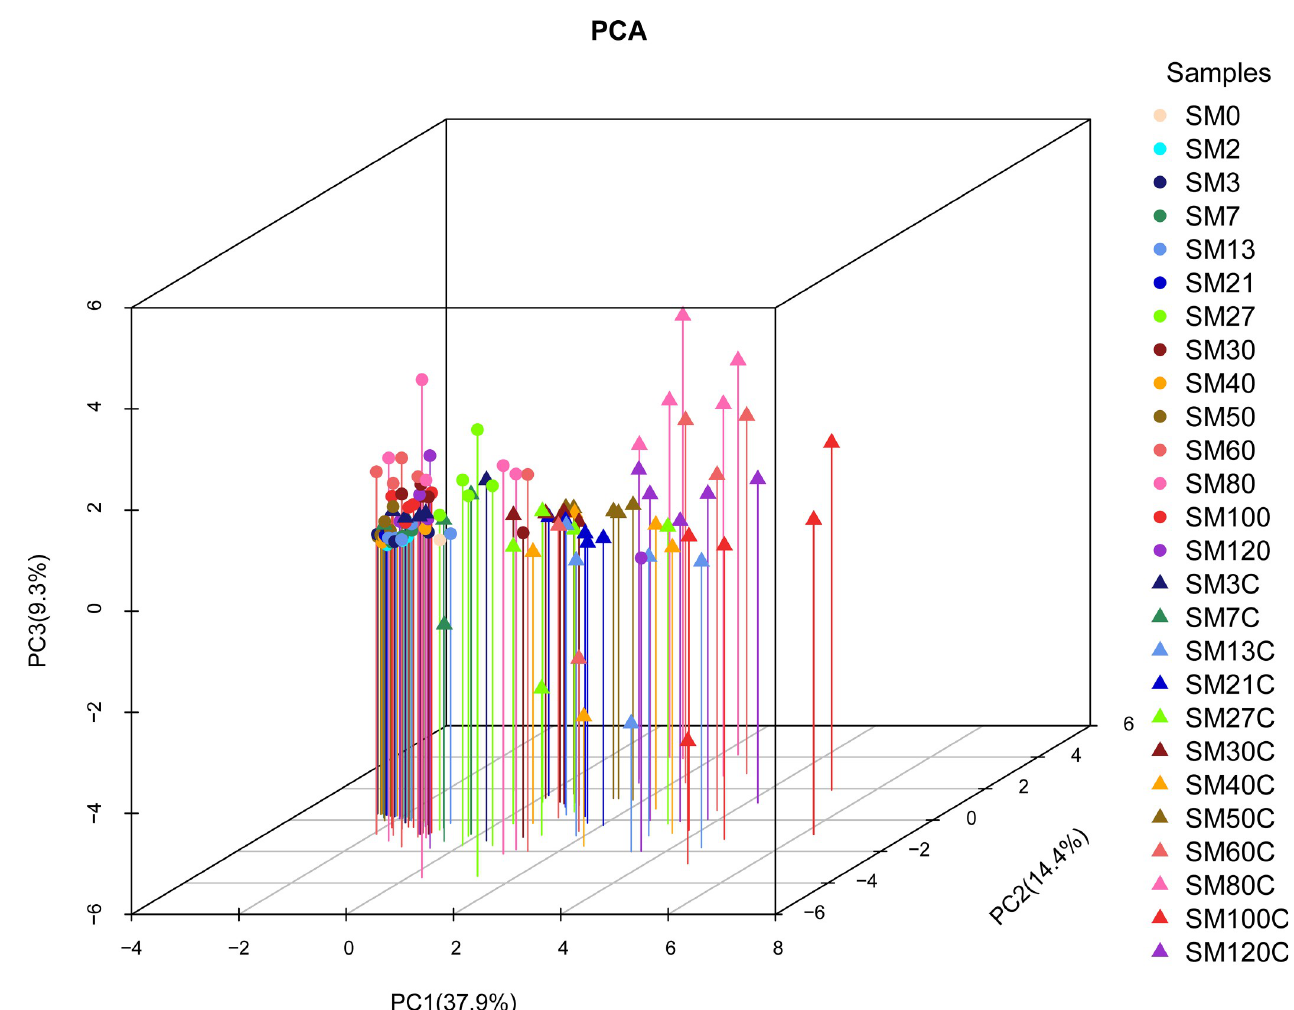
Fig 4. Principal components analysis (PCA) results based on the operational taxonomic units level in turbot larvae guts under different treatments.